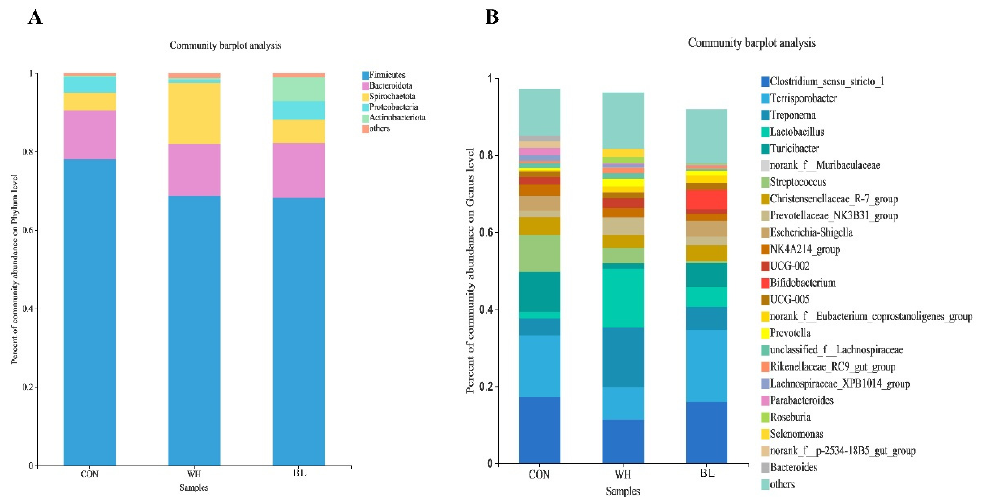
Figure 3. Relative abundance of fecal bacteria based on the phylum ( A ) and genus ( B ) level. Different color areas in the figure indicate the proportions of different species. Among them, species with an abundance less than 1% are combined as other. The individual pig was regarded as the experimental unit (n = 6). CON, basal diet group; WH, wheat diet group; BL, barley diet group. Different colors in the figure represent different bacterial communities. The higher the column, the higher the relative abundance of microorganisms. The relative abundance and proportion of each group at the phylum level could be intuitively seen from the spe- cies annotation results. Seven dominant bacteria were identified at the phylum level of pig feces. Firmicutes, Bacteroidota and Spirochaetota were the dominant phyla, accounting for 78.06, 12.39 and 4.53%, respectively, in CON treatment, accounting for 68.75, 17.18 and 15.60%, respectively, in WH treatment and accounting for 68.19, 13.91 and 5.98%, respec- tively, in BL treatment (Figure 3A). At the genus level, a total of 24 genera were detected in the three groups. Different colors in the figure represent different bacterial communi- ties. The higher the column, the larger the proportion of the sample and the higher the relative abundance. The relative abundance and proportion of each group at the genus level could be seen from the annotation results. The dominant bacteria in CON treatment were Clostridium_sensu_stricto_1 , Terrisporobacter and Turicibacter . The proportions were 17.19, 16.05 and 10.44%, respectively. The dominant bacteria in WH treatment were Lactoba- cillus, Treponema and Clostridium_sensu_stricto_1 , accounting for 15.24, 15.47 and 11.34%, re- spectively. The dominant genera in BL treatment were Terrisporobacter, Clostrid- ium_sensu_stricto_1 and norank_f_Muribaculaceae , accounting for 18.81, 15.98 and 8.06%, re- spectively (Figure 3B). Lefse analysis was used to analyze and identify bacteria with significant differences at the gate level between the three treatments (Figure 4, LDA = 2). In CON, WH and BL treatment groups, bacteria in 11, 8 and 9 were significantly enriched.